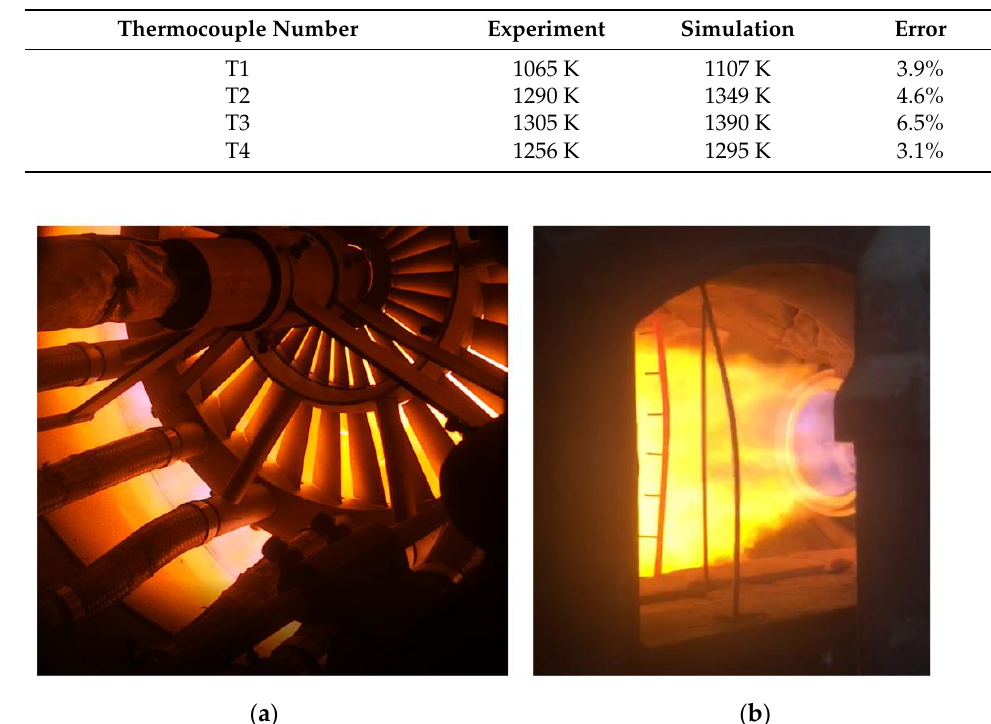
Figure 3. Photographs of the rear ( a ) and front ( b ) positions of the